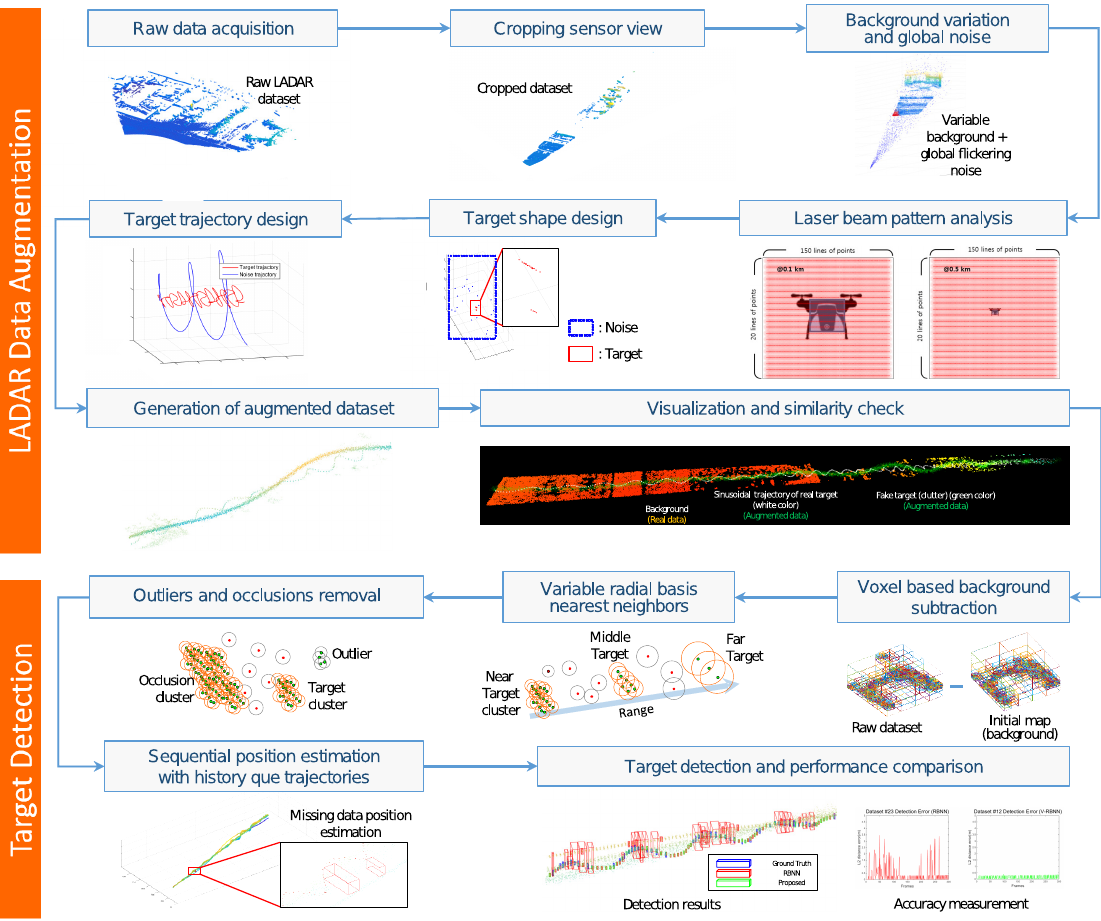
Figure 1. A flow chart for the small drone detection